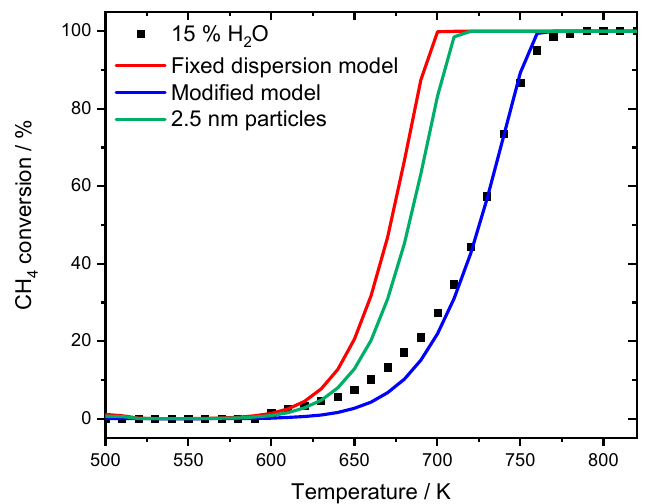
Figure 8. Light-o ff measurements for the experimental results for PdO / Al 2 O 3 in 3200 ppm CH 4 , 12% H 2 O, 10% O 2 in N 2 (black dots). The red curve represents the simulation results with the fixed dispersion and the blue curve shows the modified model with adaptation of the accessible catalytically active area. Simulating the new obtained mean particle size with 2.5 nm leads to the green line, underestimating the e ff ect of the water